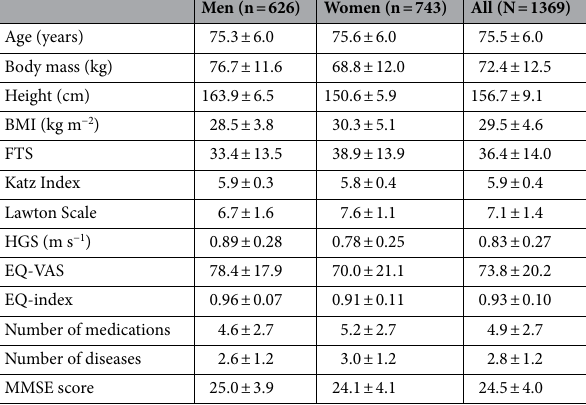
Table 1. Main characteristics of the study participants. Data are presented as mean ± standard deviation. BMI body mass index, FTS frailty trait scale, HGS habitual gait speed, EQ-VAS EuroQol visual analogue scale, EQ-index EuroQol index, MMSE mini-mental state